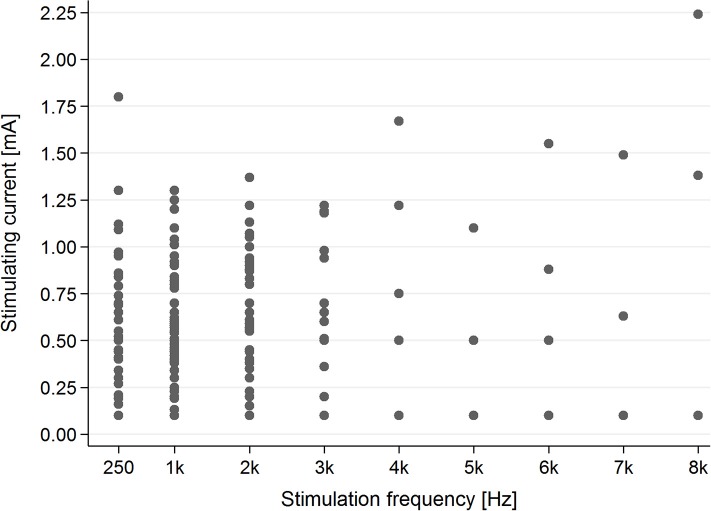
The presence of the AP in the tinnitus group for particular stimulating current parameters (mA/kHz).